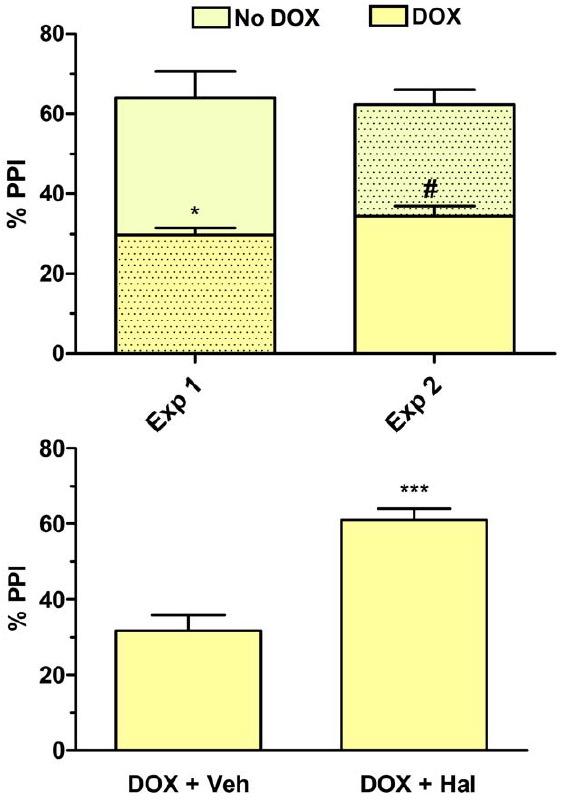
Figure 7. Percentage of PPI in IR-hCB1 -/- mice under different conditions. All values represent the mean 6 S.E.M. Panel A: reversibility of Dox-induced disruption of PPI. Two groups of IR-hCB1 -/- mice have been randomly assigned to vehicle group (dotted color, n=6) or Dox group (plain color, n=7) and then tested for PPI (Exp. 1). Dox administration lasted 12 days, and extra 12 days served for the washout, after which the schedule was repeated by switching the treatments (i.e. Dox given to previous No-Dox treated mice, and vice versa) (Exp. 2). Panel B: Dox-induced disruption of PPI is antagonized by haloperidol (1 mg/kg i.p., 30 min before PPI session).